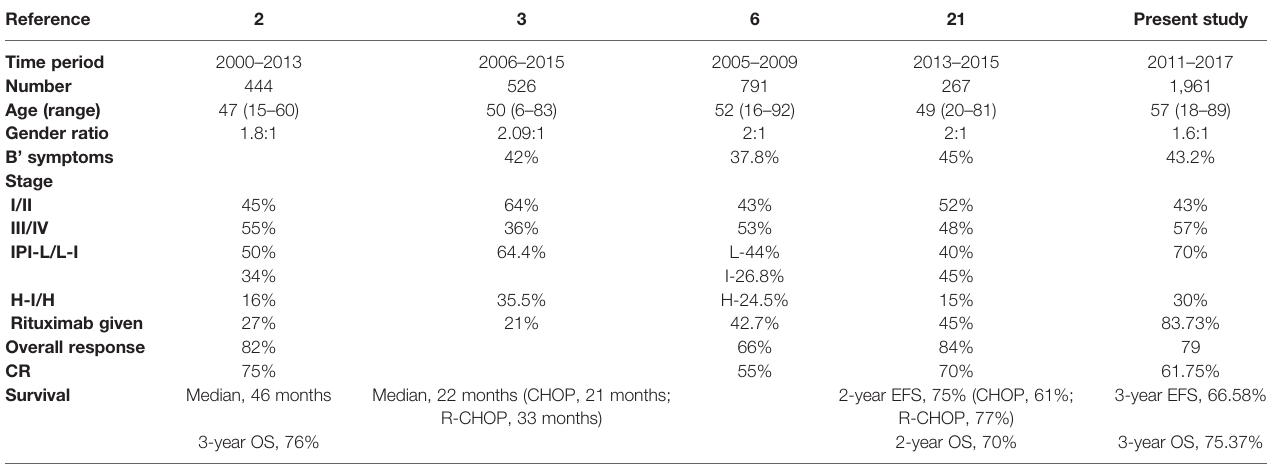
TABLE 4 | Review of DLBCL presentation and outcomes from Indian studies.